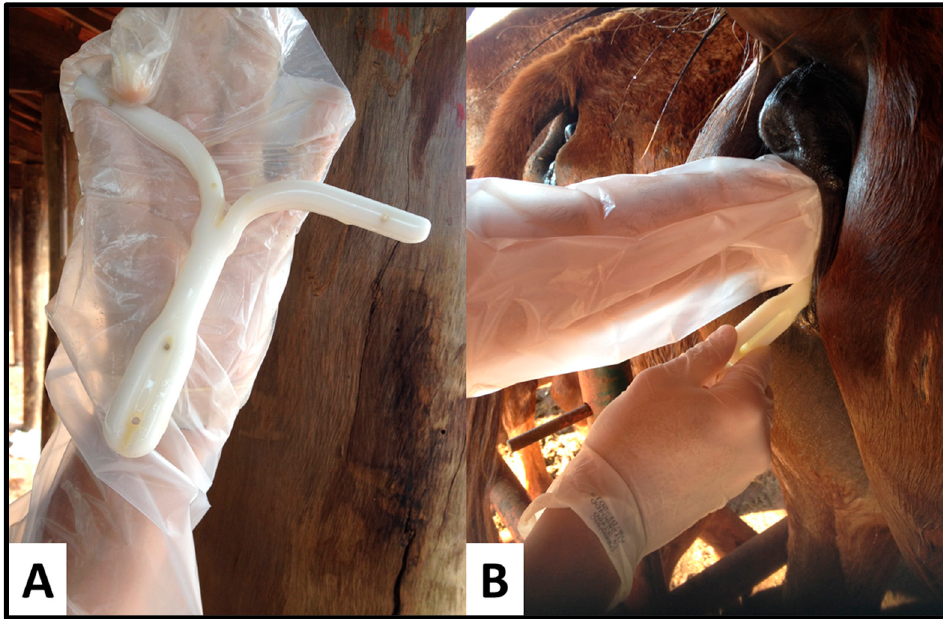
Figure 1. Placement of an intravaginal progesterone device (IPRD) (Sincrogest, Ourofino) in an acyclic mare. ( A ) The IPRD in the operator’s hand immediately after being sprayed with oxytetracycline and hydrocortisone. ( B ) IPRD while being inserted into the vagina of an embryo recipient mare. Three days after removal of the IPRD, mares were resynchronized with three consec ‐ utive days of estradiol ‐ 17 β , as described above, and a new IPRD was vaginally inserted and kept in place for three days (Figure 2). The IPRD was kept in place for three days to simulate a short resynchronization. Transrectal palpation and ultrasonographic evalua ‐ tions were performed daily from the first day of estrogen administration (D–3) until re ‐ moval of the second IPRD (D18). Uterine tone and endometrial edema were scored during each transrectal palpation and ultrasonographic examination respectively, as previously described [7]. Briefly, no visible endometrial edema was deemed as score 0, and exacer ‐ bated endometrial edema characterized by a marked orange ‐ slice appearance with rounded edged endometrial folds was deemed as score 4. Intermediate scores had varia ‐ tions in the orange ‐ slice appearance. Uterine tone score 1 had a flaccid and saggy uterus (anestrus), whereas score 3 had a well ‐ toned rounded and tubular uterus. Blood samples were collected 2, 6, and 12 h after insertion (D0 and D15) and removal (D9 and D18) of IPRD, and also daily for 16 consecutive days (D0 to D12, and D14 to D18) (Figure 2).